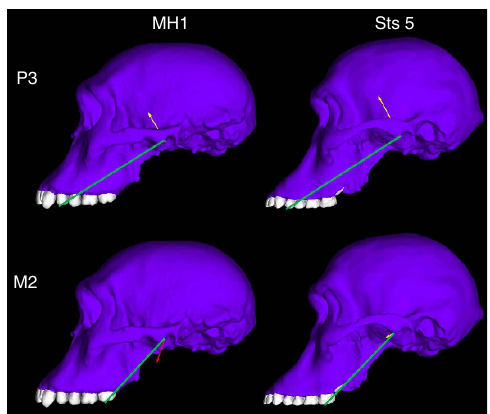
Figure 5 | Orientation of the joint reaction force at the working (biting) side temporomandibular joint (TMJ) in models of (MH1) ( A. sediba ) and Sts 5 ( A. africanus ) during simulated left premolar (P 3 ) and left molar (M 2 ) biting. Arrows indicate direction of the reaction force. Yellow arrows indicate a compressive force, while red arrows indicate a distractive force, relative to the plane of the triangle of support (green line). Note that the zygomatic root (off of which the masseter muscle arises) is more mesially positioned relative to the tooth row in MH1 than Sts 5. Models are not shown to